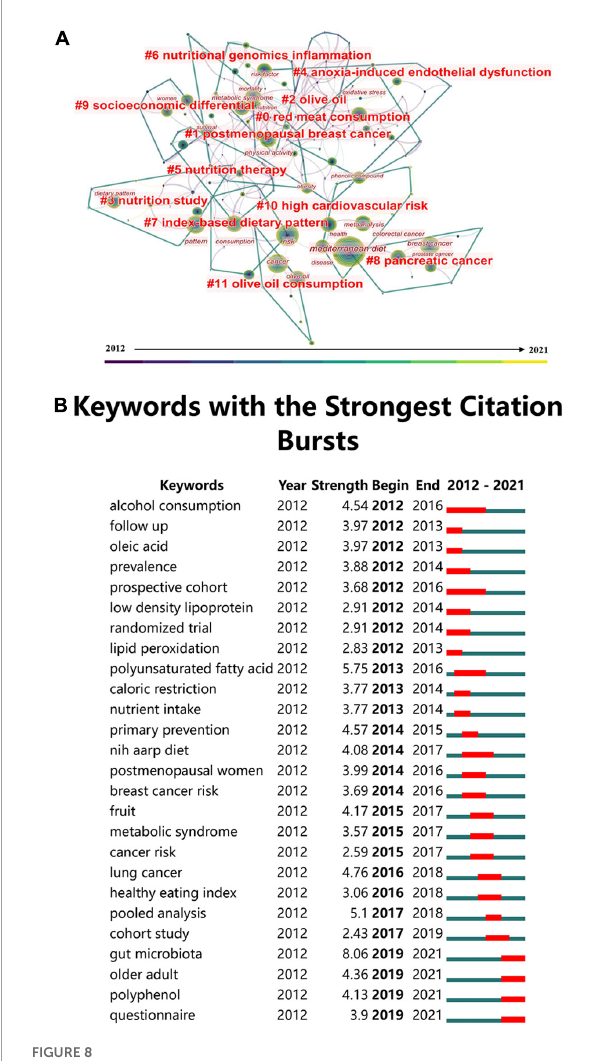
detection. The strongest keyword identified was the gut microbiota, which has been a hotspot since 2019. Interestingly, the MD